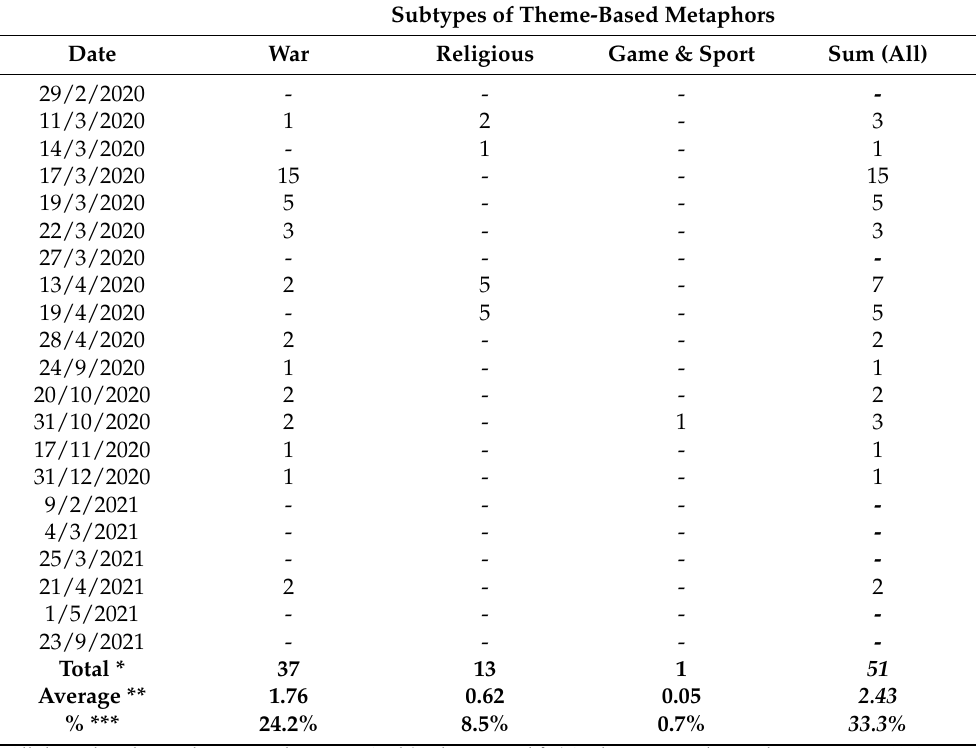
Table 2. Utilization of Different Types of Theme-Based Metaphors by the Greek PM in Public Addresses during the COVID-19 Crisis.